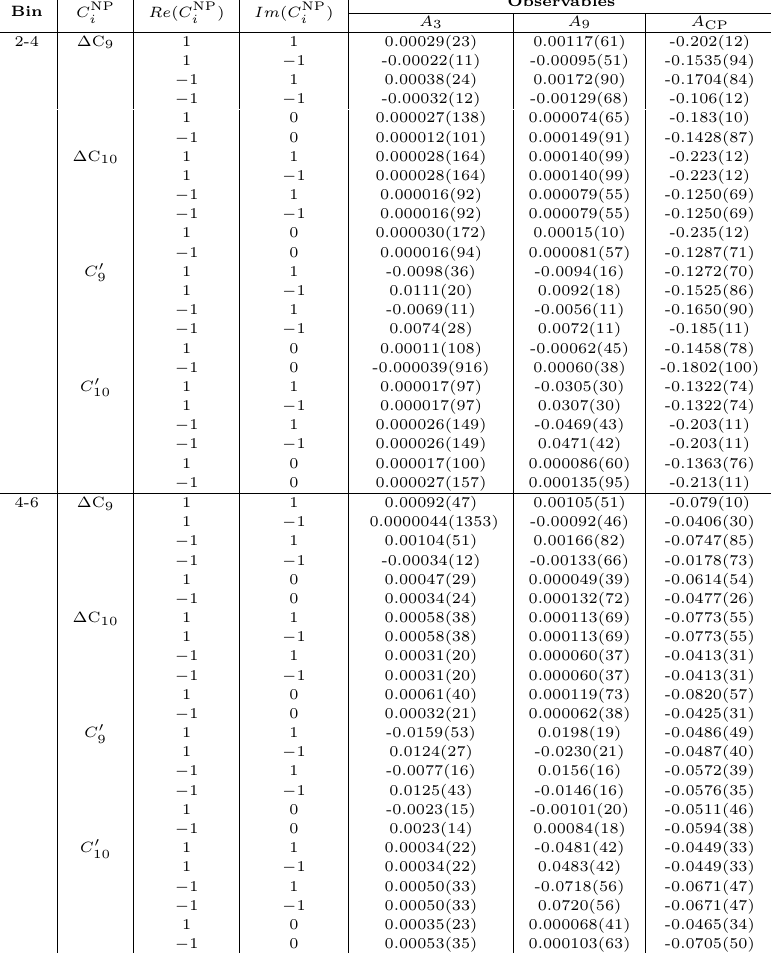
and C 0 for the q 2 bins 2 − 4 and 4 − 6 GeV 2 for a 9 , 10 9 , 10